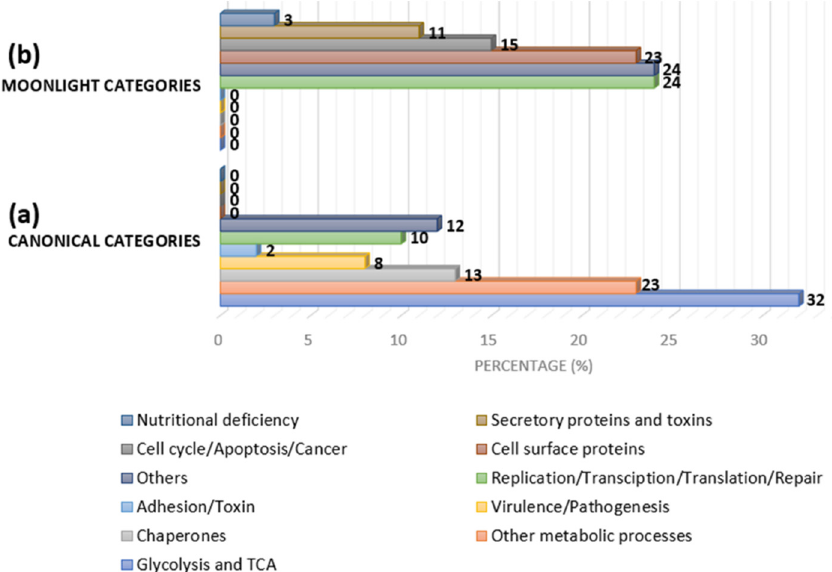
Figure 4. Approximate category distribution of MLPs based on canonical and secondary functions in bacteria: ( a ) 32% are glycolytic/tricarboxylic acid (TCA) cycle-related proteins, 23% are other metabolic pathway-related proteins, 13% are chaperones, 8% are virulence/pathogenesis-related proteins, 2% are adhesion- and toxin-related proteins, 10% are replication-, transcription-, translation-, and repair-related proteins, and the rest belong to other categories; and ( b ) 24% are replication-, transcription-, translation-, and repair-related proteins, 15% are cycle-, apoptosis-, and cancer-related proteins, 23% are cell-surface proteins, 11% are secretory toxin proteins, 3% are nutritional-deficiency-related proteins, and the rest are other categories (adapted from [44]).